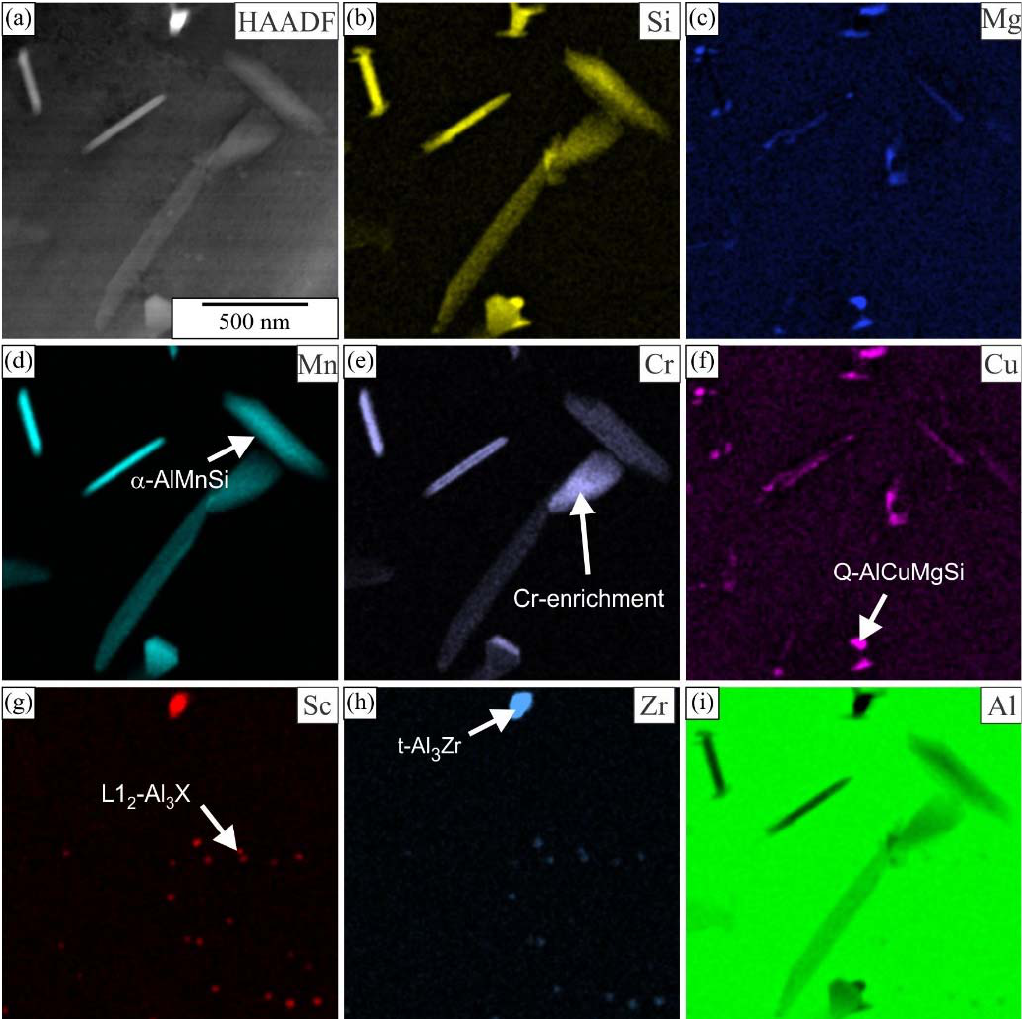
Figure 7. Distribution of the elements within the matrix of the alloy 6086-Sc after homogenization ( a ) HAADF micrograph, EDS mapping of selected elements, ( b ) Si, ( c ) Mg, ( d ) Mn, ( e ) Cr, ( f ) Cu, ( g ) Sc, ( h ) Zr, and ( i ) Al.